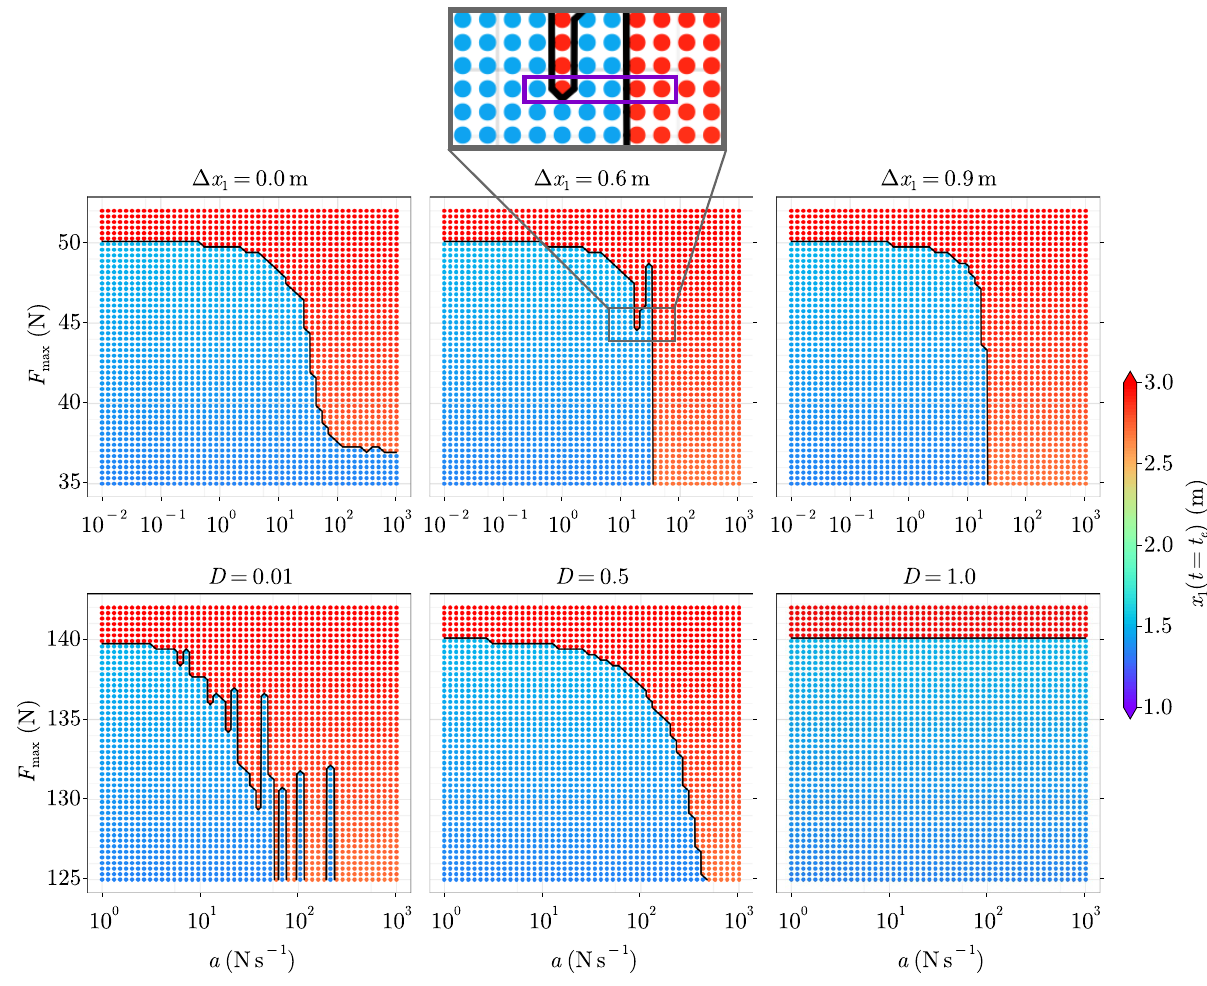
Figure 2. Deterministic tipping pattern of the PLO in the ramp-parameter space for (top row) (cid:31) x 1 0.32m and (bottom row) D 0.6m . In the bottom row, 0, 0.6, 0.9 m and D 0.01, 0.5, 1 and (cid:31) x 1 ≃ = = { } = { } the eigenfrequency of the PLO is increased by reducing the mass as specified in Table 1 of the supplementary material. The black curve represents the separation function F min,tip ( a ) . The time series associated with the points in the violet rectangle of the top-centre panel are visualised in Fig.